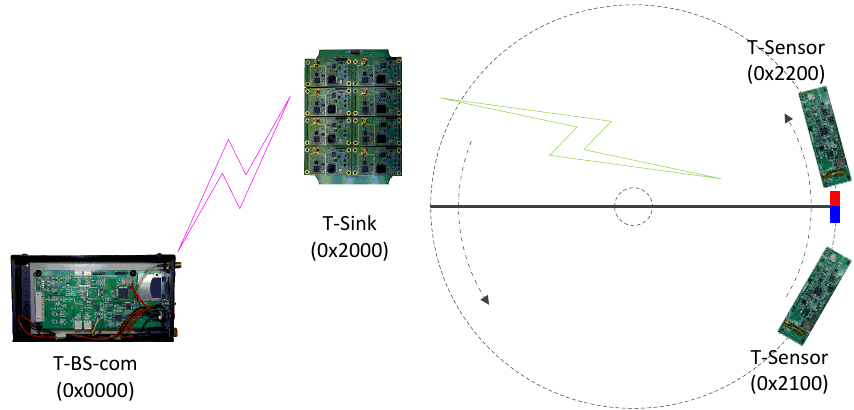
Figure 11. Indoor testbed for evaluating